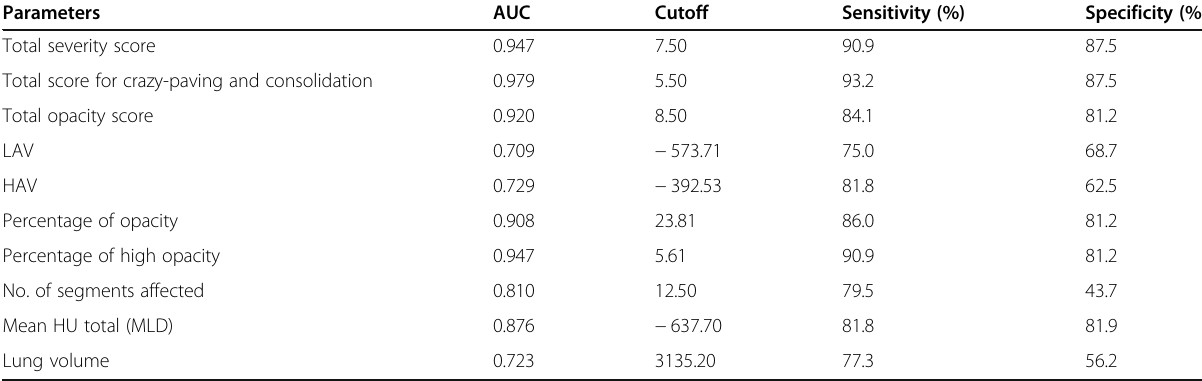
Table 3 Validity of different parameters in relation to the clinical grouping (mild vs moderate and severe)